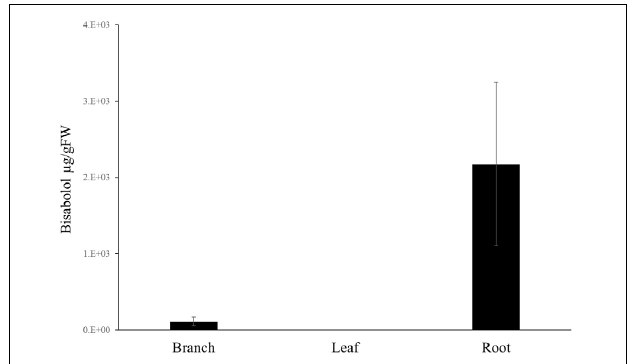
FIGURE 3 | Bisabolol content in different tissues. (–)- α -Bisabolol was extracted with dichloromethane and quantified by GC-MS for different tissues originating from Candeia trees. Each bar is the average of at least three biological replicates ±